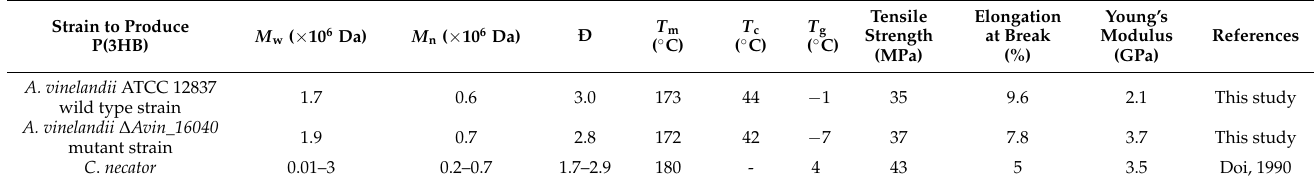
Table 4. Characteristics of P(3HB) produced by A. vinelandii ATCC 12837 wild type and ∆ Avin_16040 mutant strains. Strain to Produce